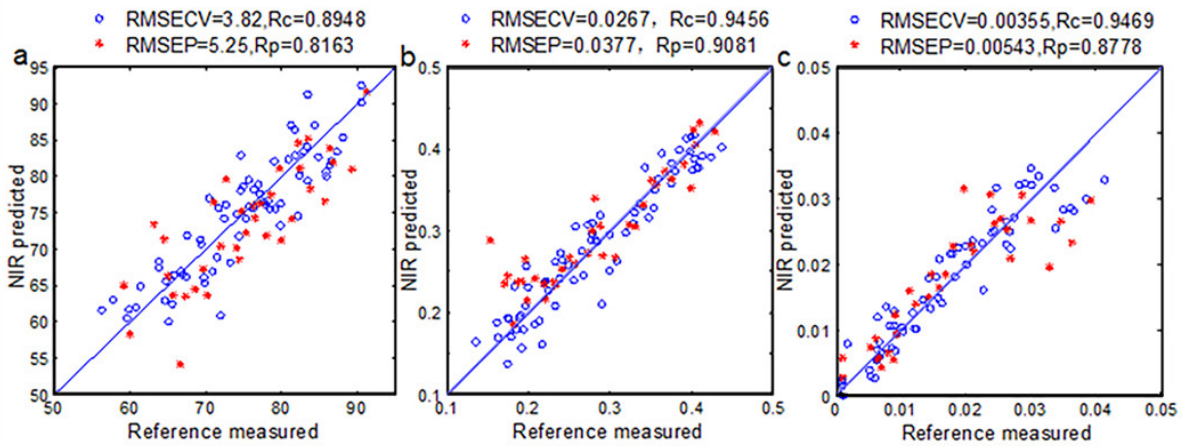
Figure 4. Correlation between reference measured and NIR predicted of the Haugh Unit ( a ), yolk index ( b ) and weight loss rate ( c ) in egg samples. (Storage temperature was 25 °C).